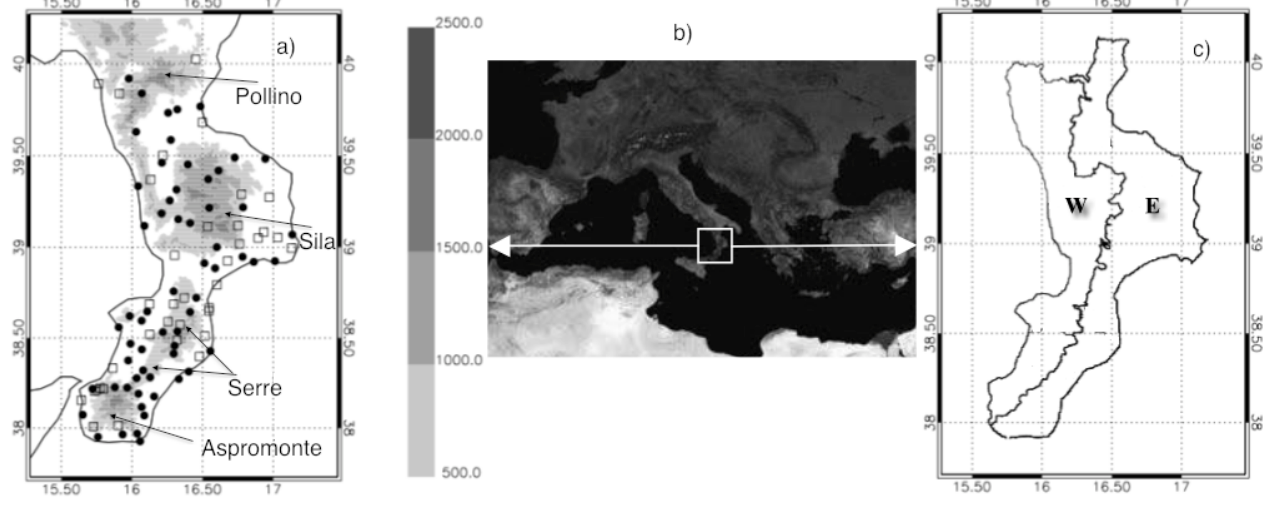
Fig. 1. Panel (a) the regional rain gauge network; panel (b) Calabria region in the central Mediterranean; panel (c) the two sub-regions (see